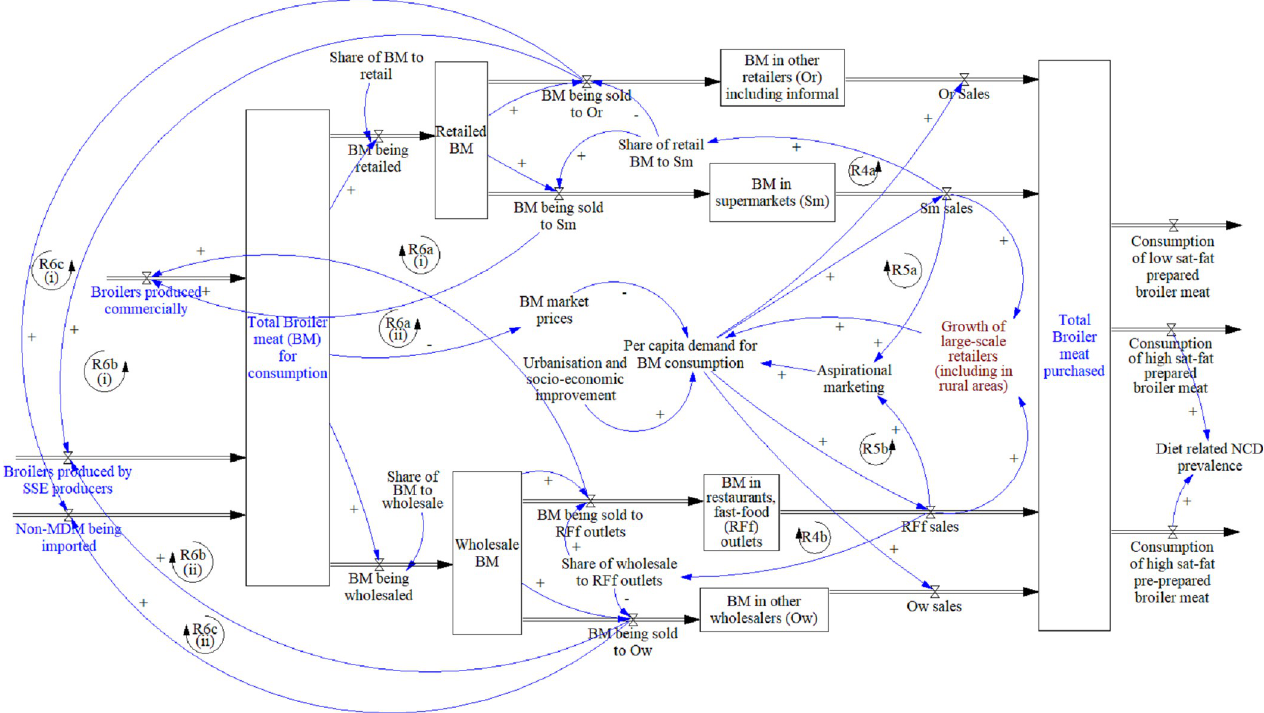
Fig 4. Distribution and consumption module. Key: Blue text: elements linking to other modules, Brown text: elements added after meeting with stakeholders. Abbreviations: BM = broiler meat, SM = supermarkets, Or = other retailers, RFf = restaurants and fast-food, Ow = other wholesalers, NCD = non- communicable diseases.